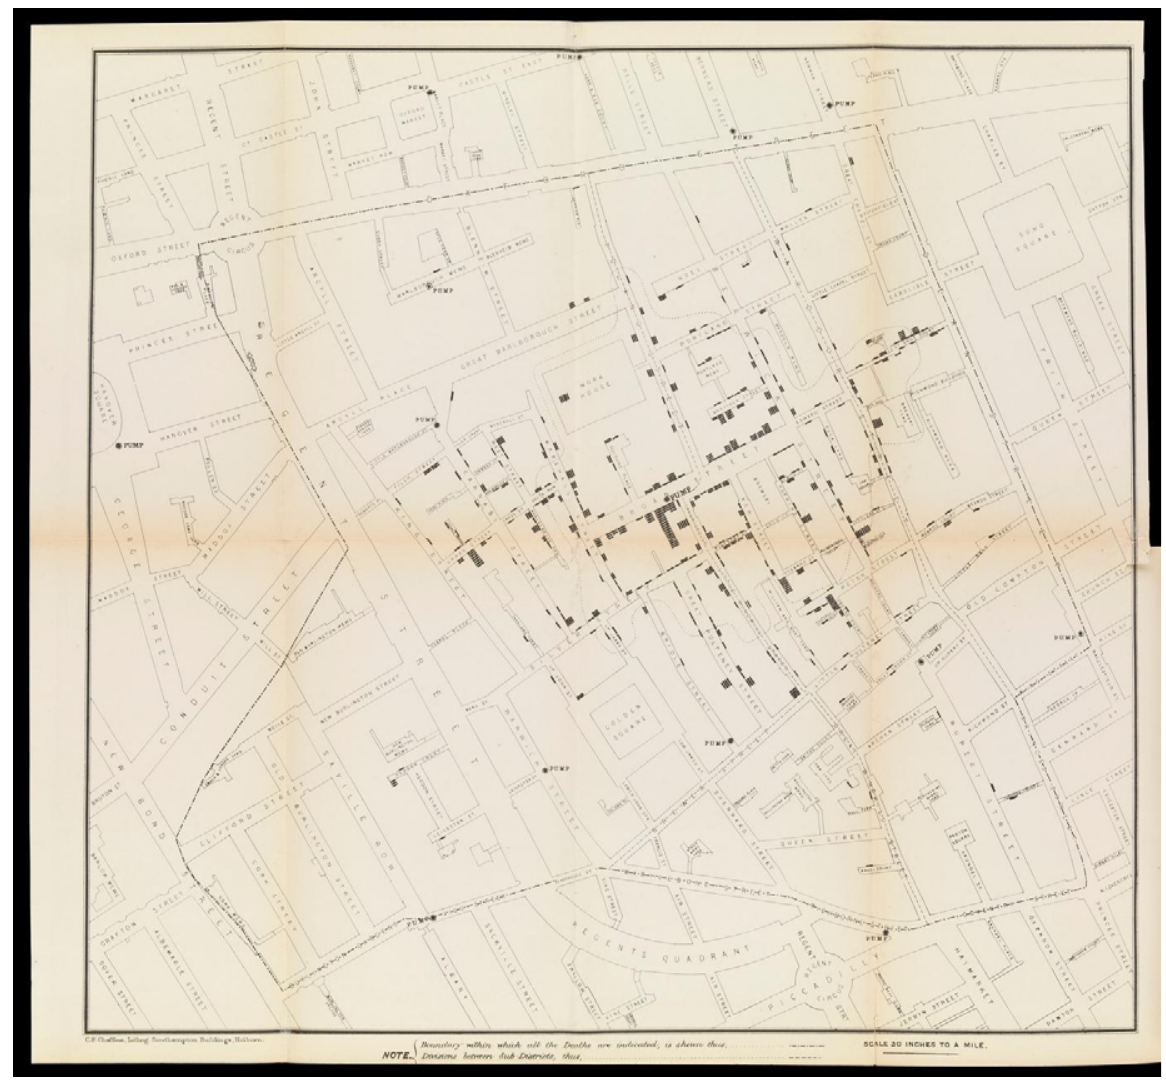
FIG. 3 Map produced by John Snow showing the correlation between cholera and drink - ing water distribution points along Broad Street, July 1855. Source: Wellcome Library,